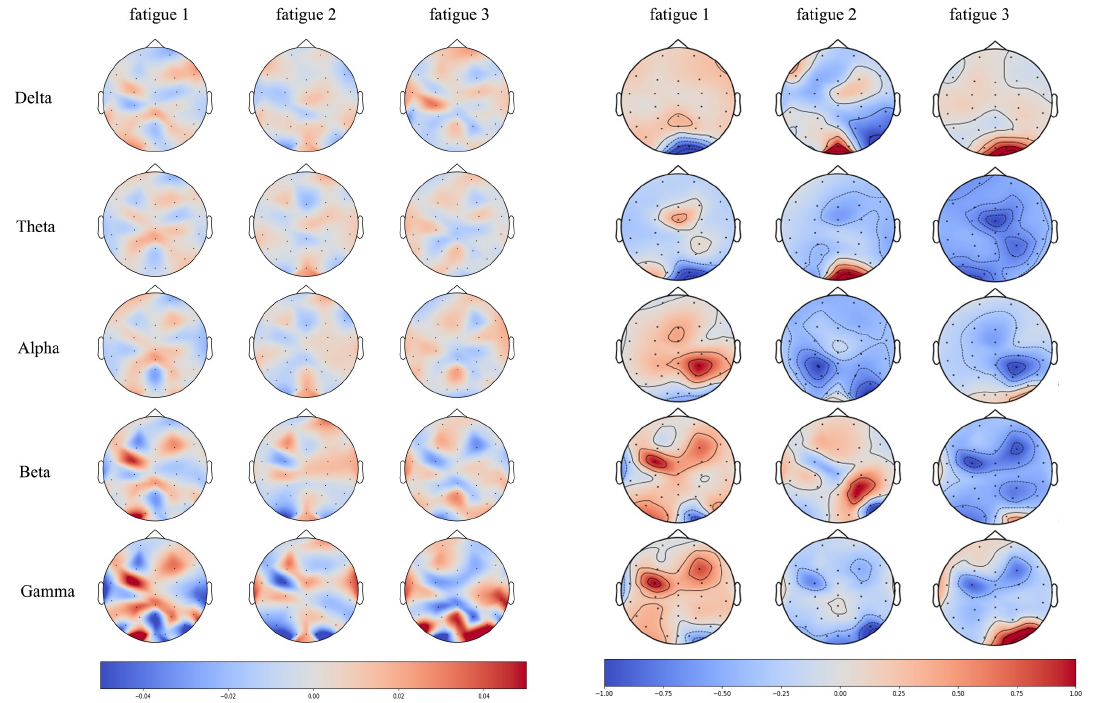
Figure 5. Correlation maps between input perturbation and dense output ( left ), as well as spatial maps for power spectral density (PSD) difference ( right ), for various frequency bands and fatigue levels. Note that PSDs in the figure (right) are the differences between the PSD of corresponding one fatigue level and that of the rest